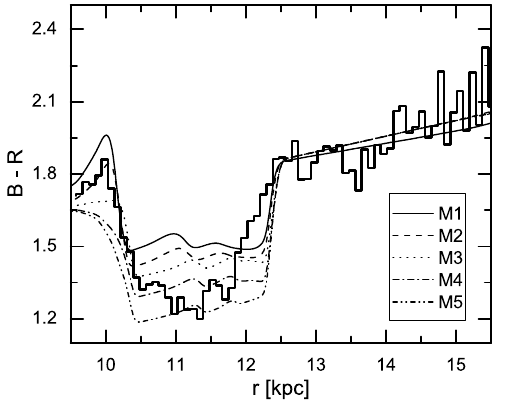
Fig. 2. Radial color profiles: step line – observations; different lines – mod- els from Table